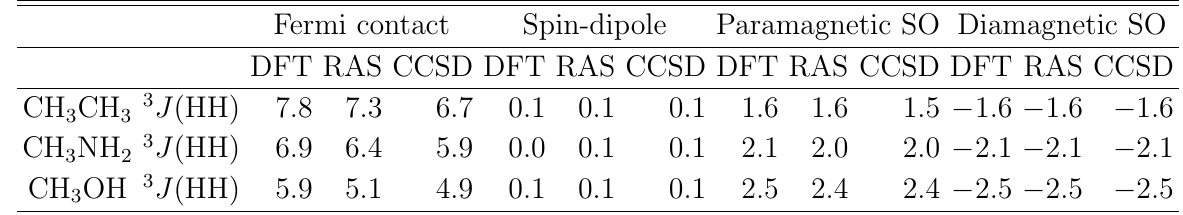
Table 6: Comparison of individual contributions to the vicinal coupling constants calculated at the DFT, RASSCF a and CCSD